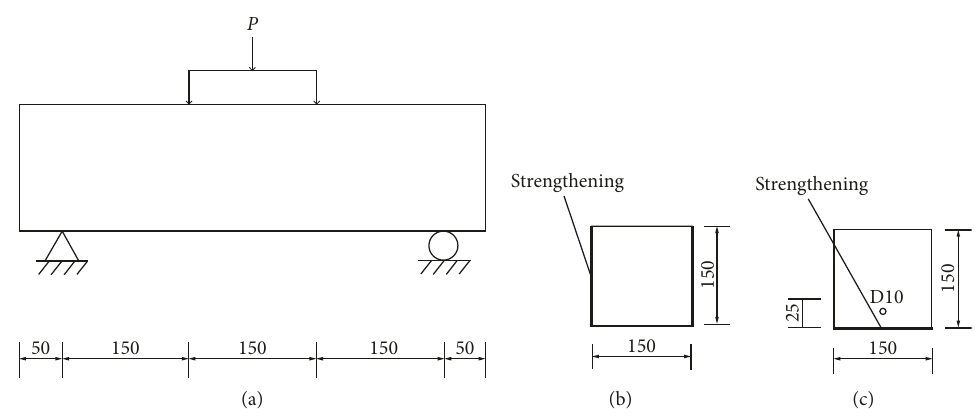
Figure 2: (a) Experiment of coated beam (unit: mm) of specimen under two-point loading, (b) strengthening at three faces without reinforcing bar, and (c) strengthening at a single face with reinforcing bar.